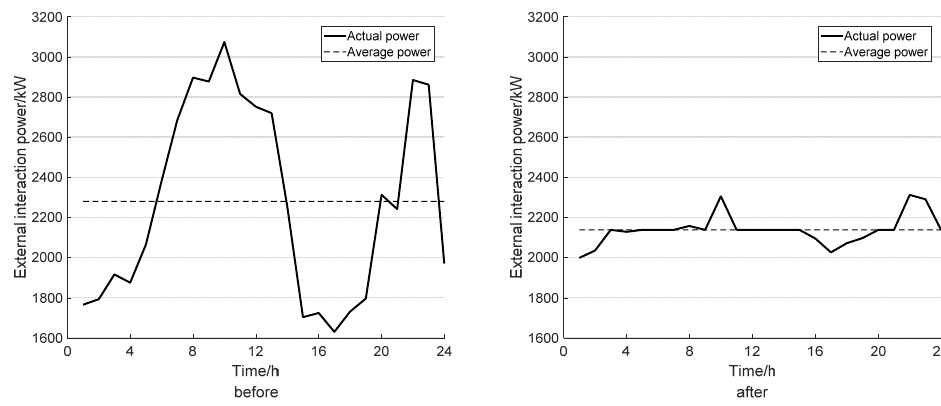
Figure 6. Total cluster output on target load curve fitting effect.